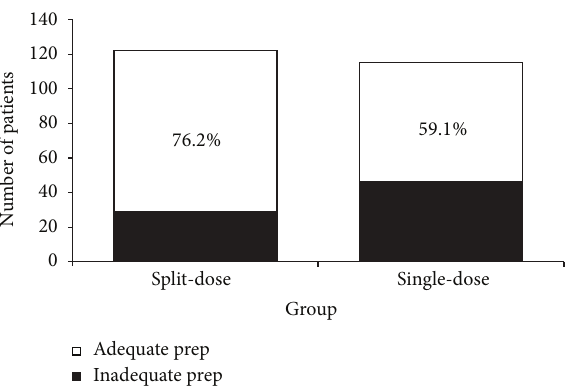
Figure 2: Proportion of patients with adequate bowel preparation (Ottawa Bowel Prep score < 6) for split-dose and single-dose PEG lavage groups.